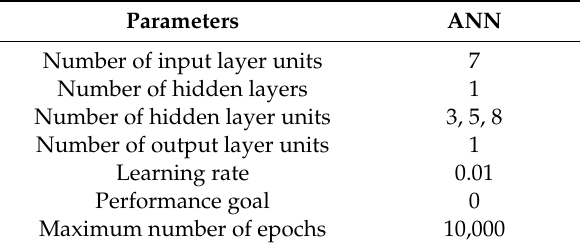
Table 3. The values of neural network parameters used in NN